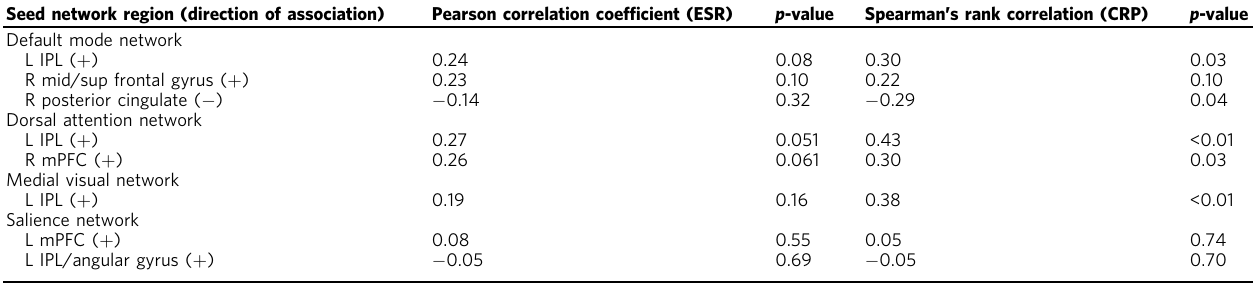
Table 2 Region-of-interest functional connectivity replication analysis at 6 months Seed network region (direction of association) Pearson correlation coef fi cient (ESR)